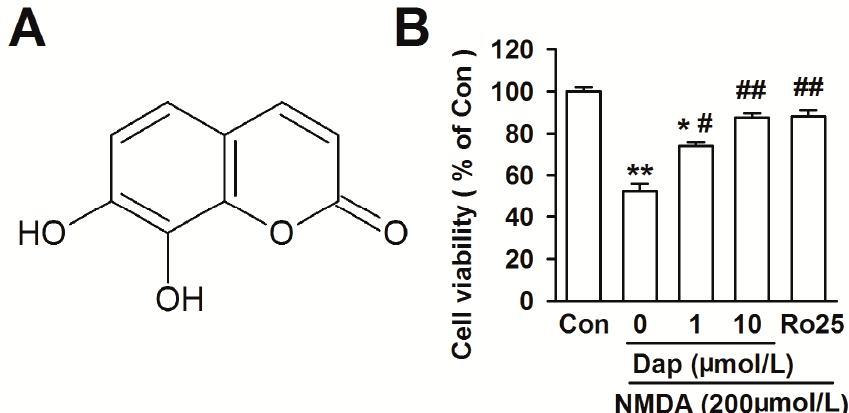
Figure 1. Effects of Dap on cell viability in cultured cortical neurons. ( A ) Chemical structure of Dapexin. ( B ) Effects of Dap (0.1, 1 and 10 μ M) and Ro 25-6981 (0.3 μ M) on the cell viability of cortical neurons after exposure to NMDA. The data were pooled from three independent experiments. * p < 0.05, ** p < 0.01 compared with control. # p < 0.05, ## p < 0.01 compared with NMDA